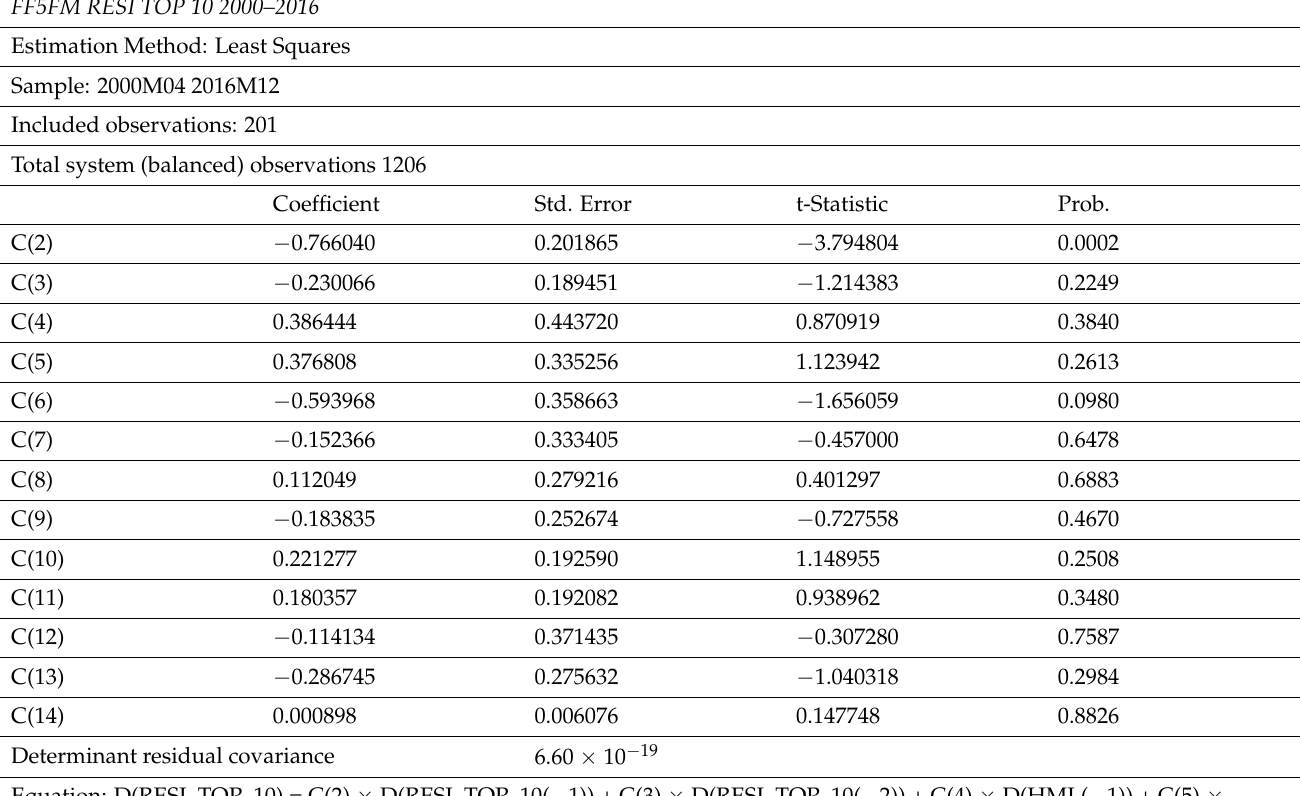
Table 9. Fama and French five-factor